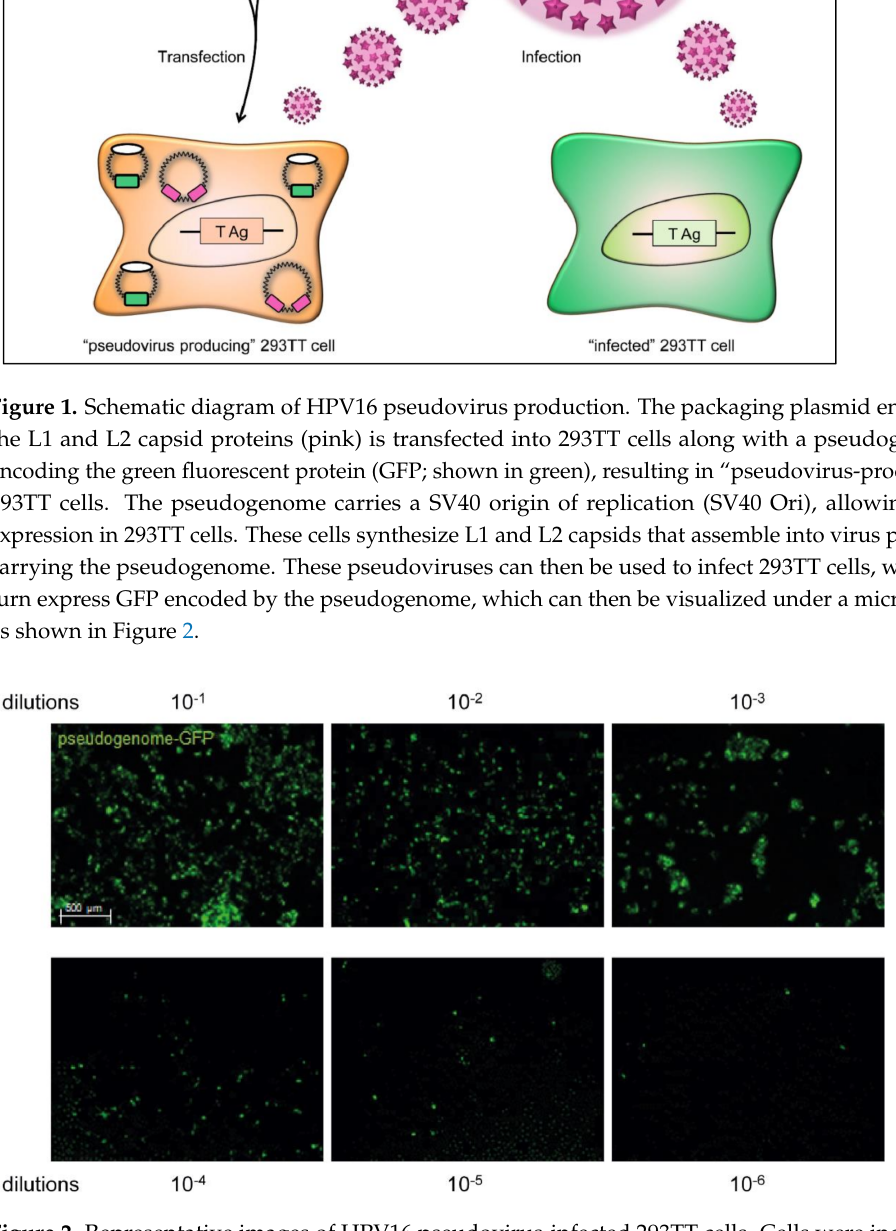
Figure 2. Representative images of HPV16 pseudovirus-infected 293TT cells. Cells were incubated with 10 − 1 to 10 − 6 dilutions of HPV16 pseudovirus and cultivated for 48 h. 293TT cells expressing HPV16 pseudogenome-GFP appear in